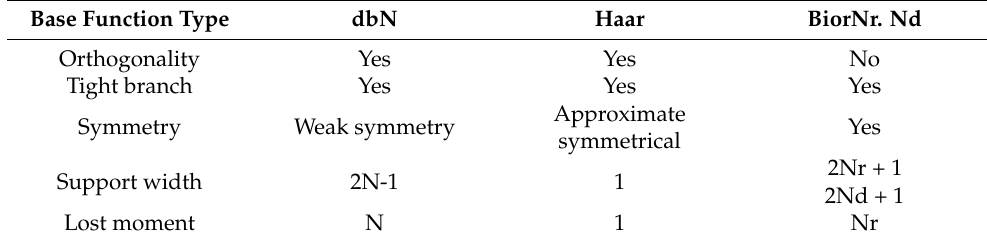
Table 4. Characteristic table of common wavelet basis function.